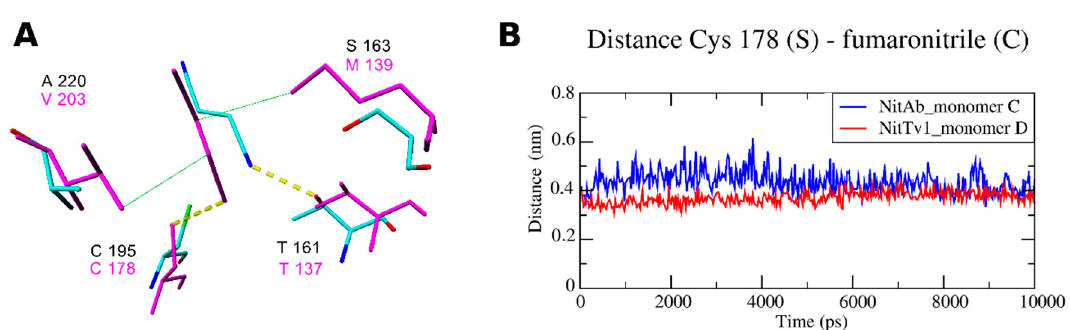
Figure 5. ( A ) Overlay of NitTv1 monomer D (magenta color) and NitAb monomer C (element color) with docked fumaronitrile after 10 ns of molecular dynamics (MD) simulations. The selection of the representative monomers was based on the lowest ligand root means square deviations (RMSD) and distance from catalytic C residue. ( B ) Distance between catalytic C residue and fumaronitrile in representative monomers during MD simulation.